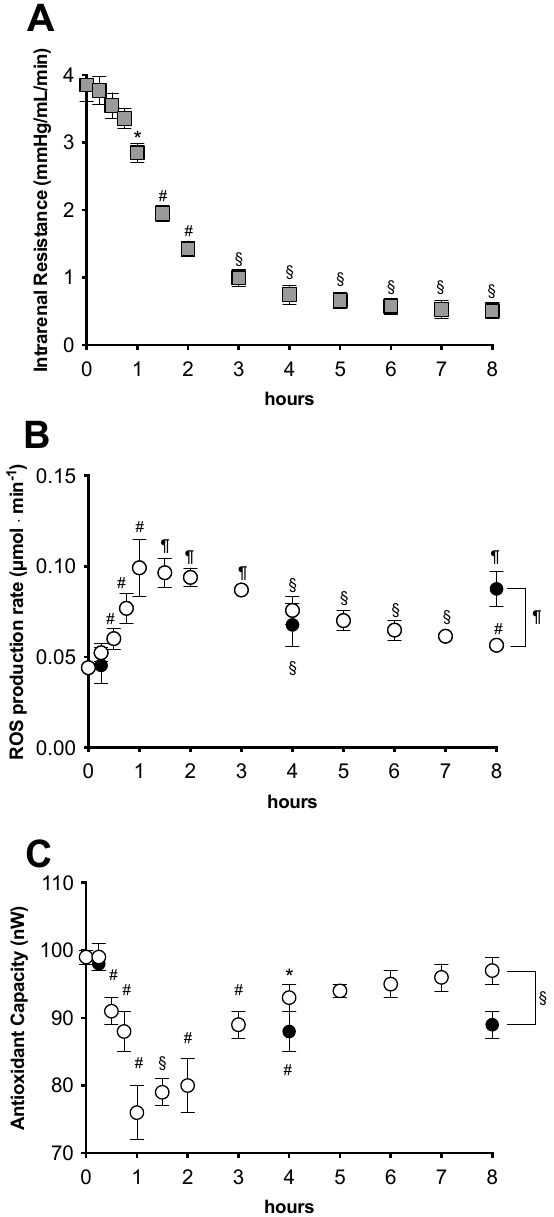
Figure 2. Intra-operative monitoring data. ( A ) Intra-renal resistance during hypothermic kidney machine perfusion (HMP, mmHg/mL · min); ( B ) EPR-measured reactive oxygen species production rate (ROS, µ mol · min − 1 ); and ( C ) Antioxidant capacity (TAC, nW) during static cold storage (SCS, full symbols) and hypothermic machine perfusion (HMP, empty symbols). The results are expressed as mean ± SD. Significant differences: * p < 0.05; # p < 0.01, § p < 0.001, and ¶ p < 0.0001.